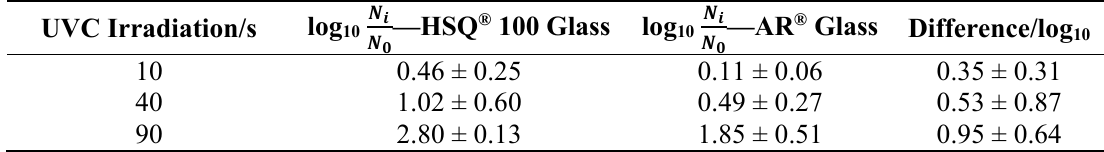
Figure 11. Disinfection results in log 10 for E. coli (1–3 × 10 6 CFU/mL) without additional mixing during UVC irradiation. Table 2 . Inactivation results for HSQ ® 100 and AR ® glass types for E. coli DSM 498 after different UVC irradiation periods and the corresponding differences of microbial inactivation in log 10 in stagnant